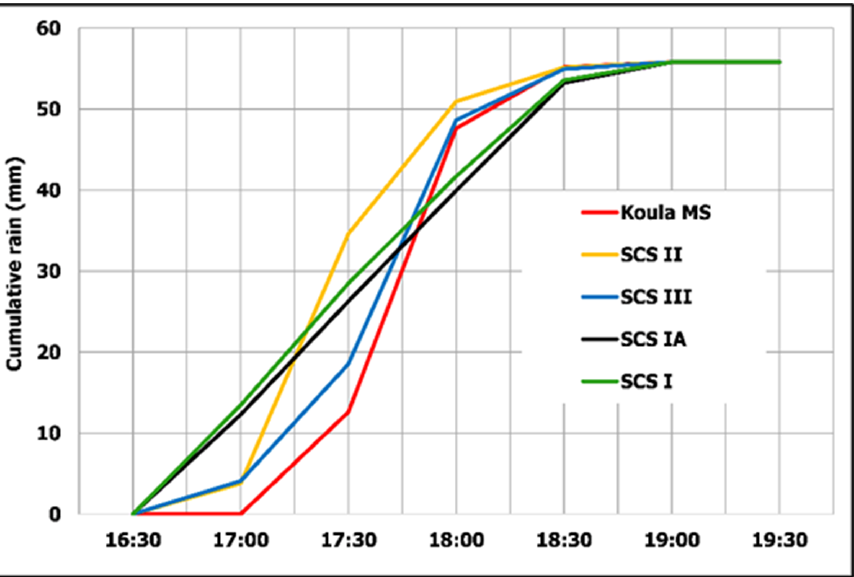
Figure 4. Disaggregated cumulative rainfall event (3 August 2015, 55.8 mm) using SCS storm types (I, IA, II, III) compared with the observed data (Koula MS).